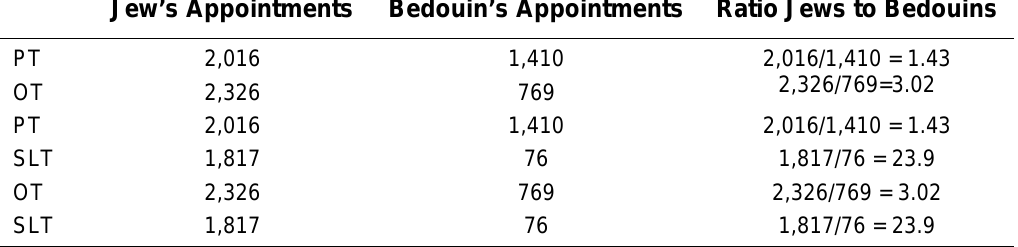
The Ratio between the Appointments of Bedouin and Jewish Children at the Zusman